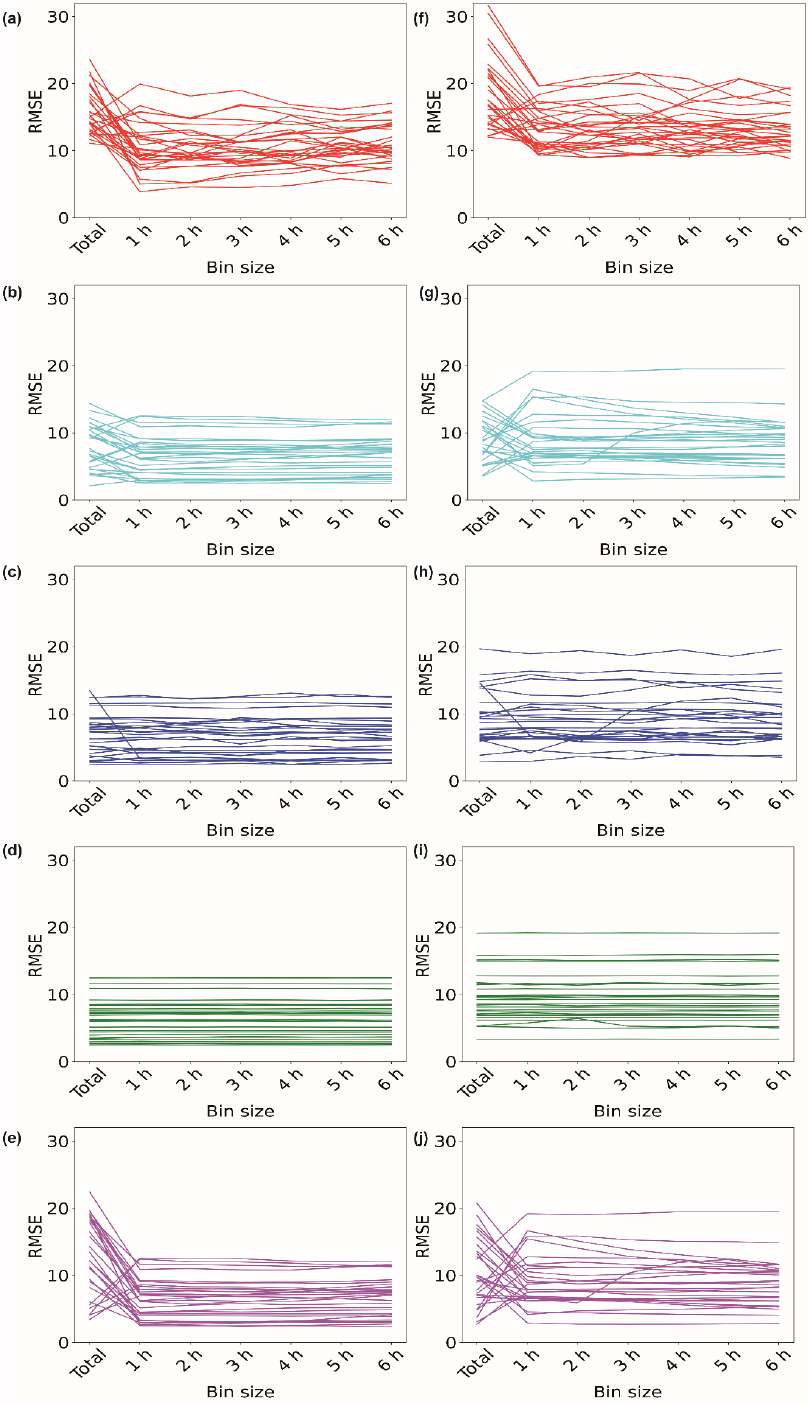
Figure 2. Imputation of 1 h of missing data. Variations in RMSE when data of different bin sizes were used for imputing missing data of ‘inactive’ period of 3–4 am using ( a ) EM, ( b ) II, ( c ) kNN, ( d ) RF, and ( e ) SI methods. Variations in RMSE when data of different bin sizes were used for imputing missing data of ‘active’ period of 3– 4 pm using ( f ) EM, ( g ) II, ( h ) kNN, ( i ) RF, and ( j ) SI methods.